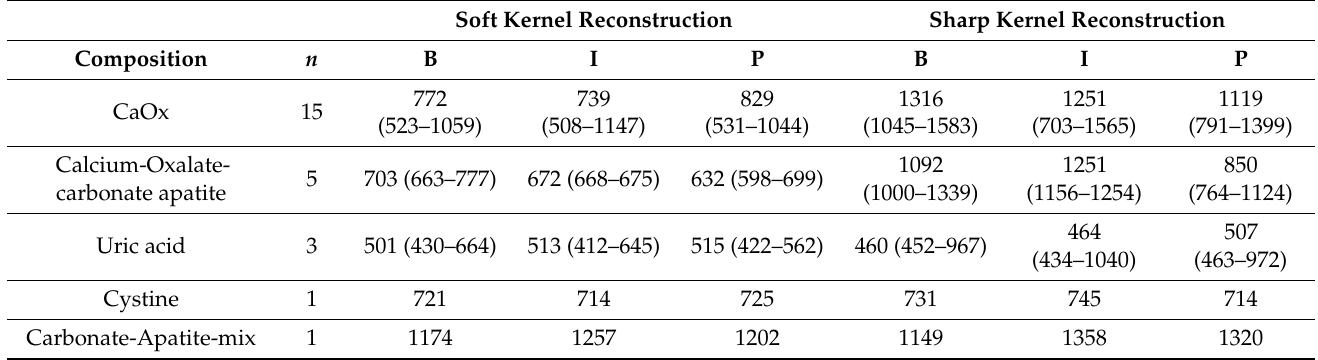
Table 3. Composition of the stones and corresponding attenuation values where results of X-ray diffraction were available. Data provided as median with 25%- and 75%-quartiles in parentheses, where n > 1 stone was available.